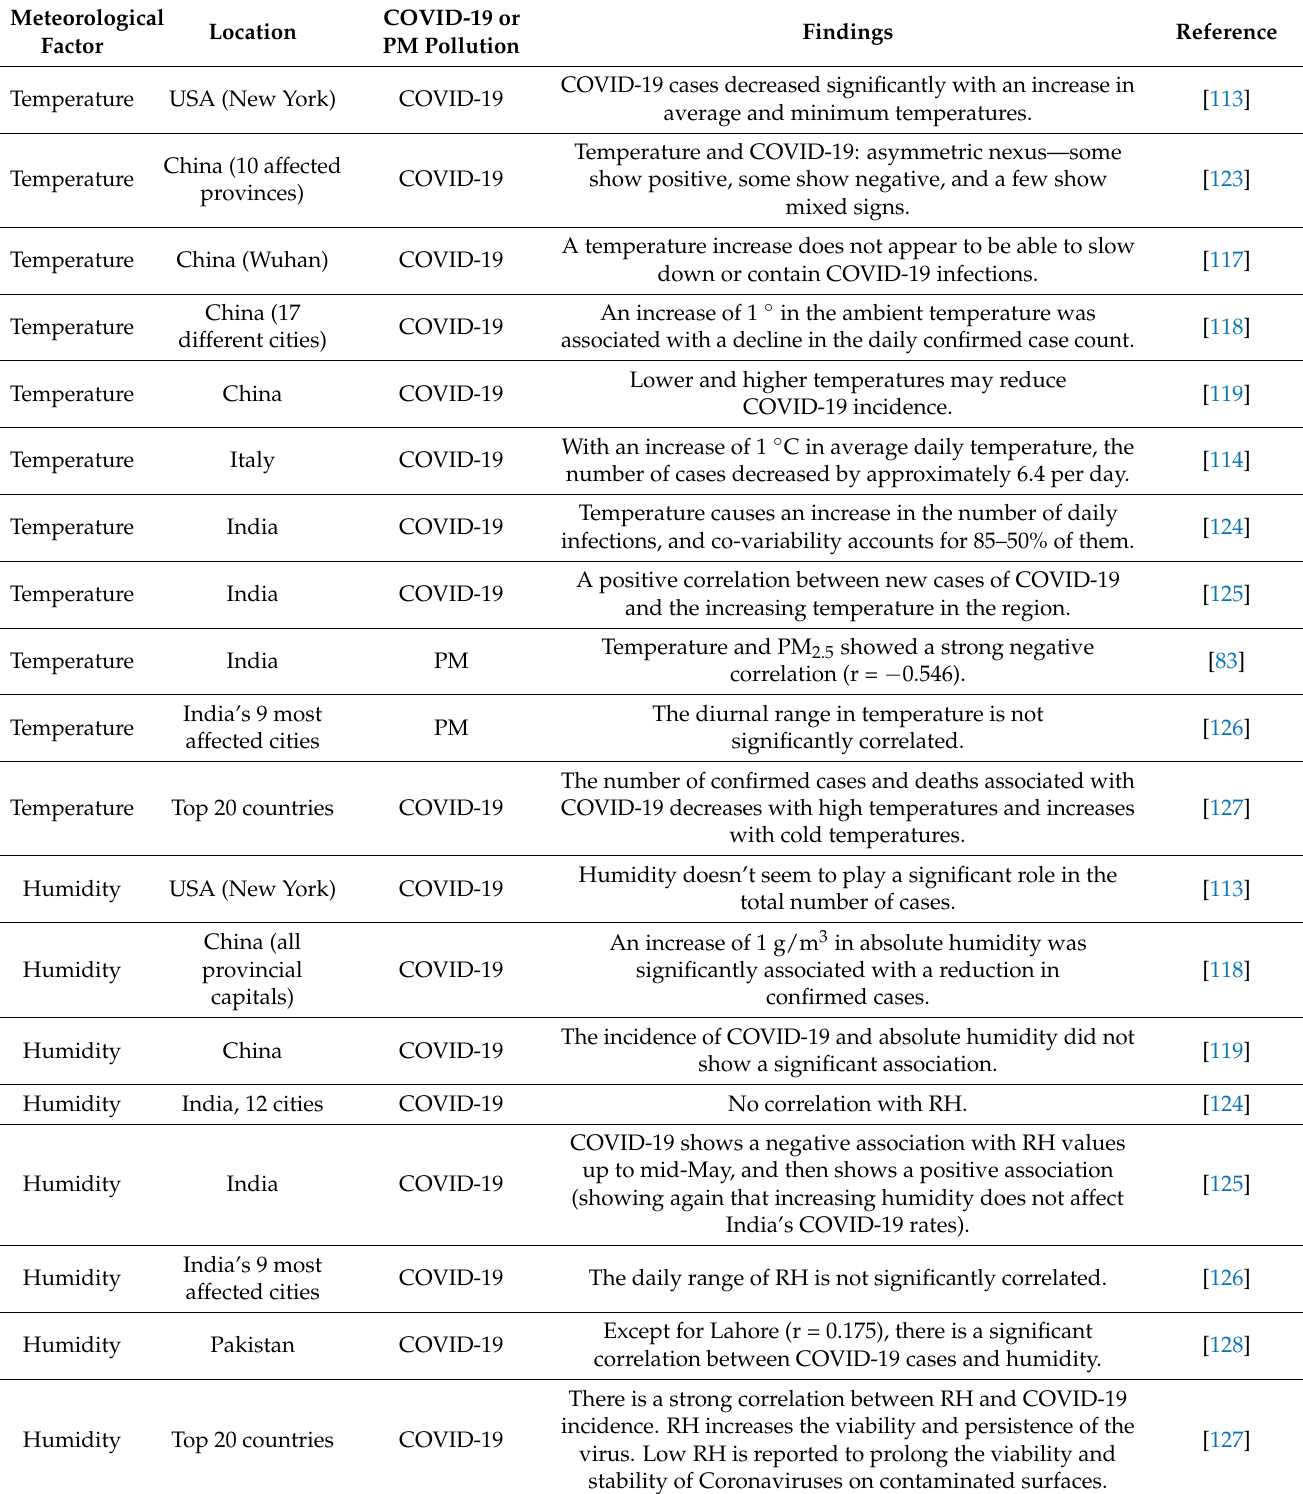
Table 2. Meteorological factors’ effects on COVID-19 and PM